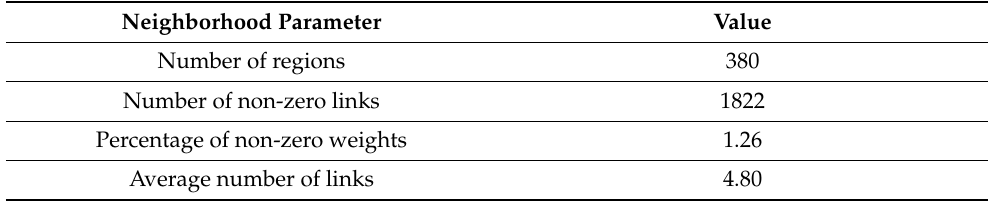
Figure 9. Neighborhood structure. It shows a global structure wherein most plots are connected. Table 2. Spatial neighborhood information. Table 2. Spatial neighborhood